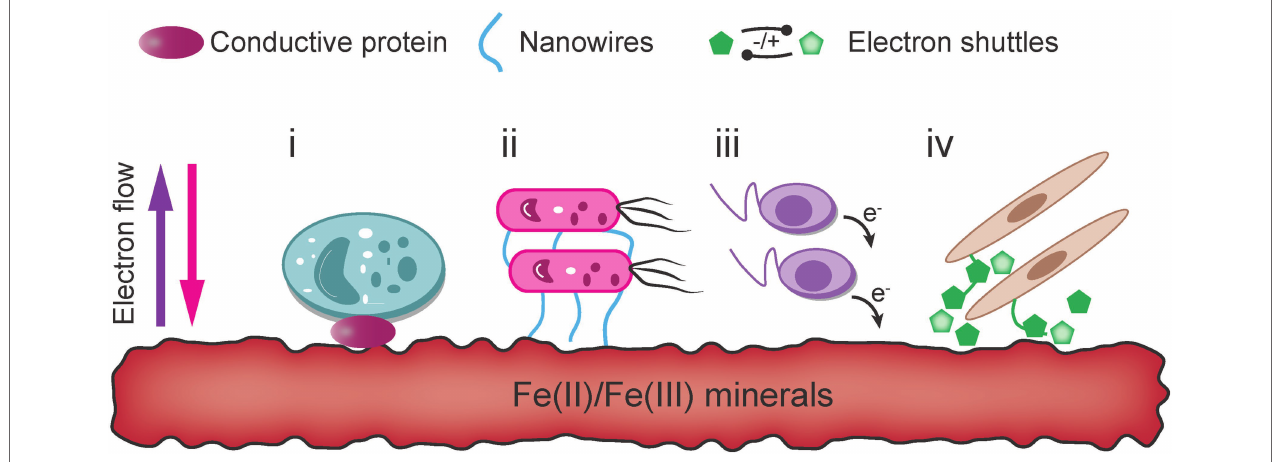
FIGURE 5 | Mechanisms of extracellular electron transfer for iron-metabolizing extracellular respiratory bacteria (Li et al.,